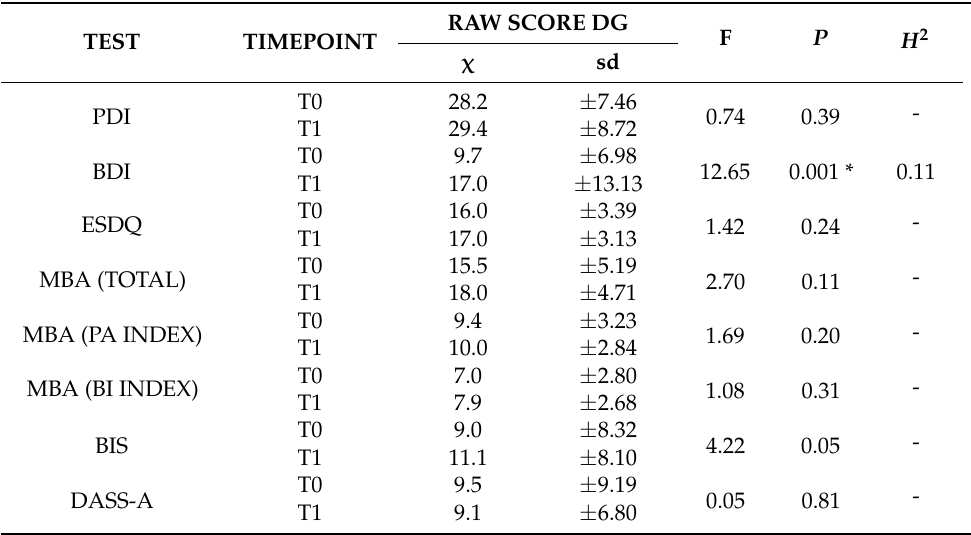
Table 4. Raw Score of Psychological measurements and Repeated Measures ANOVA for Research Protocol 2.